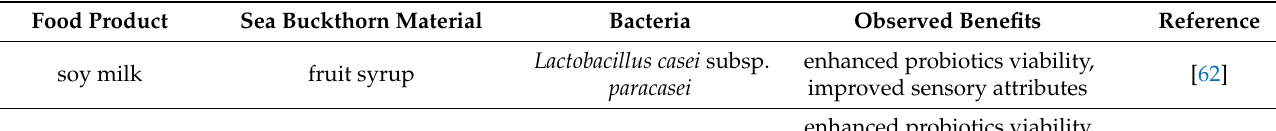
Table 3. Summary of studied probiotic non-dairy products containing sea buckthorn fruit component. Food Product Sea Buckthorn